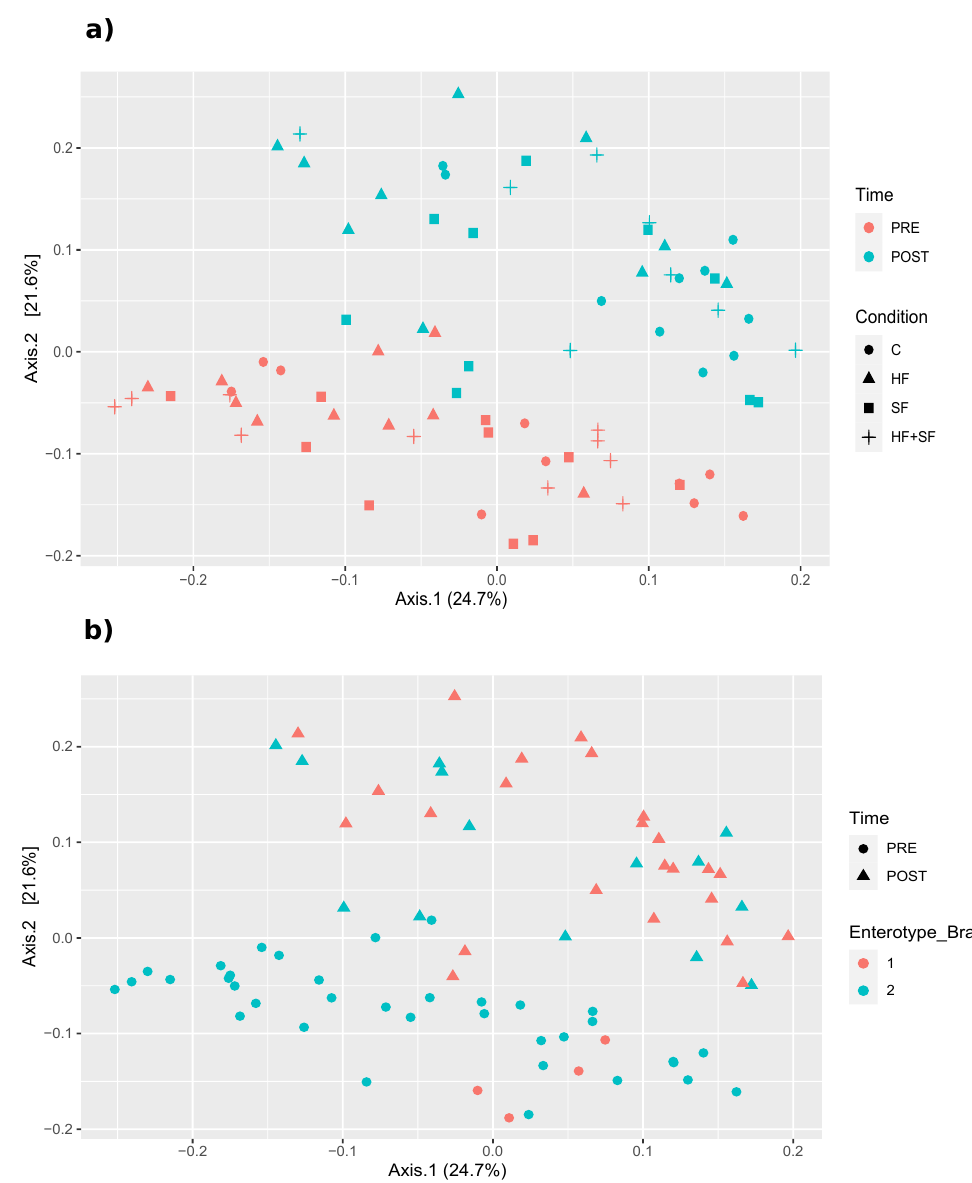
Figure 2. Stratification of the samples. MDS plots based on Bray–Curtis dissimilarity. ( a ) The samples are colored according to the Time and shaped according to Condition variable ( b ) The samples are colored according to the Enterotype variable calculated according to the Bray–Curtis dissimilarity and shaped according to the Time